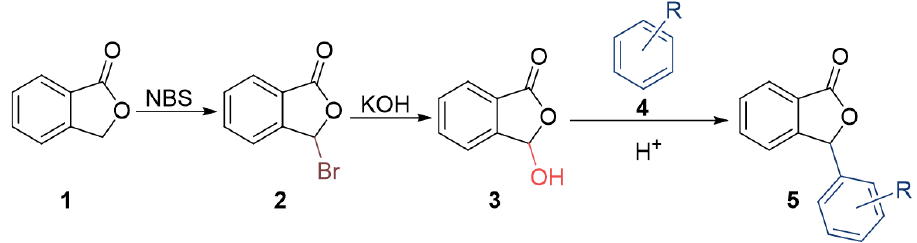
Figure 2. Synthesis of 3-arylphthalides.